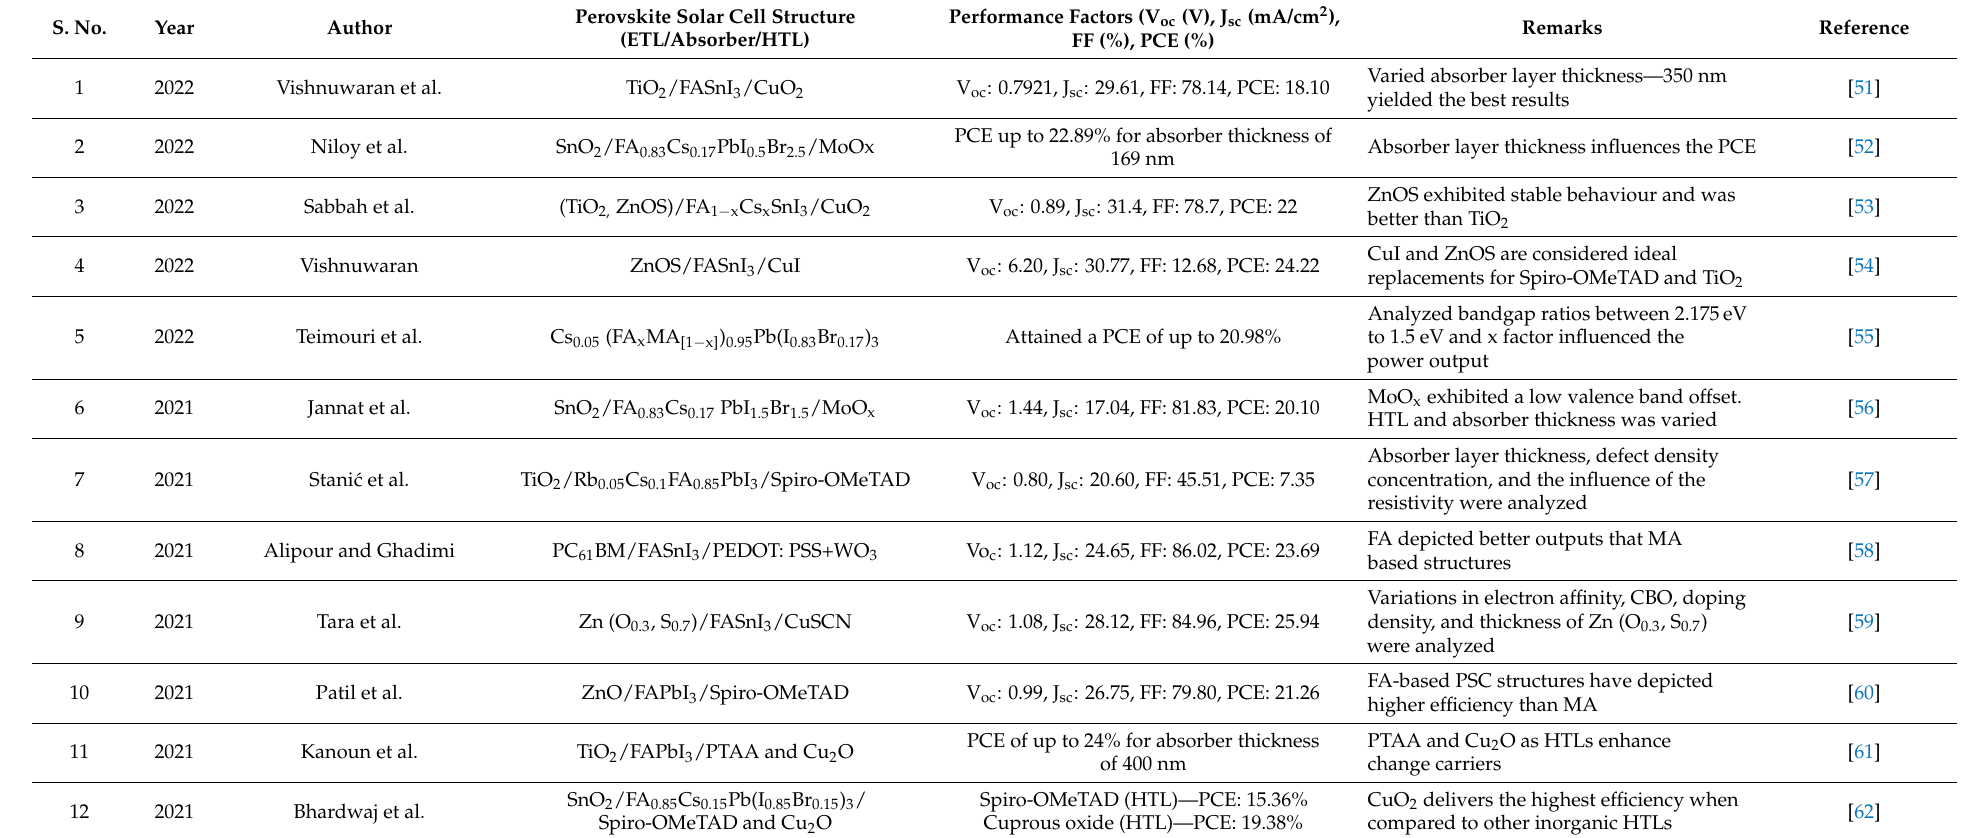
Table 2. Recent simulations that report various organic and inorganic HTLs adopted in an FA-based PSC structure (2022–2021). S.